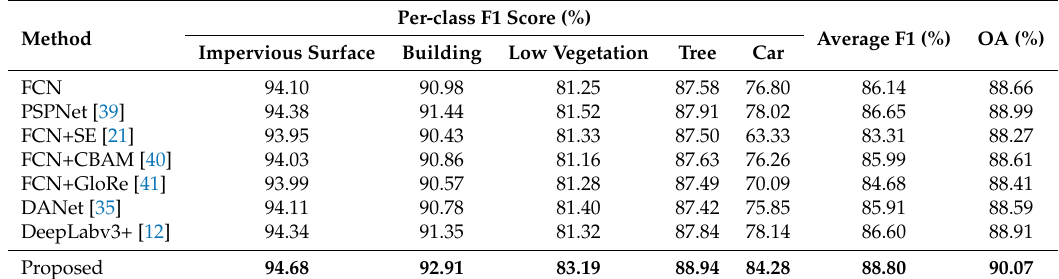
Table 4. Results on the Vaihingen dataset in terms of per-class F1 score, average F1 score, and OA. Method